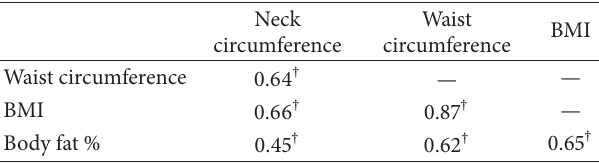
Table 2: Pearson’s partial correlations between anthropometric measurements ∗ .